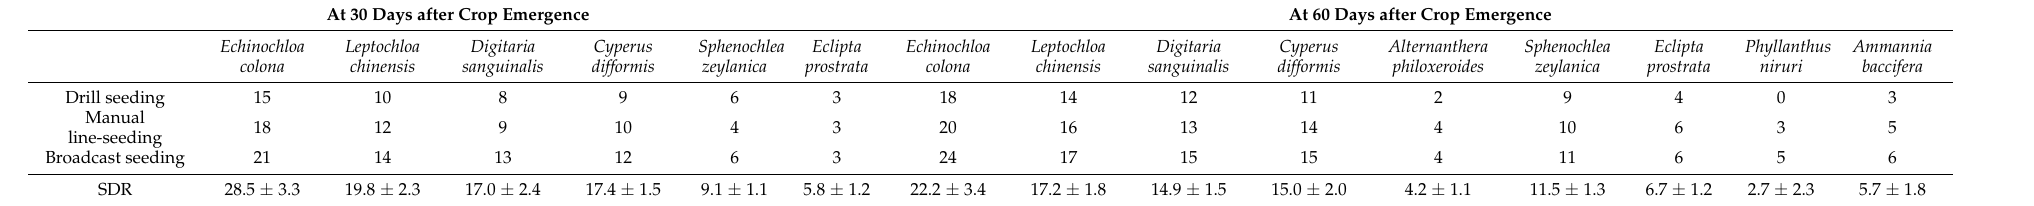
Table 1. Weed composition in weedy plots and their summed dominance ratio (SDR) ± SE (standard error)